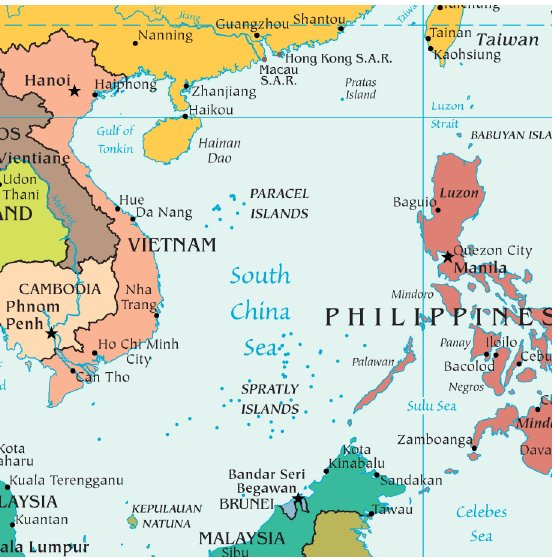
Fig 1. The South China Sea. Map modified from http://www.lib.utexas.edu/maps/middle_east_and_asia/ southeast_asia_pol_2013.pdf, available at University of Texas Perry-Casta ñ eda Library Map